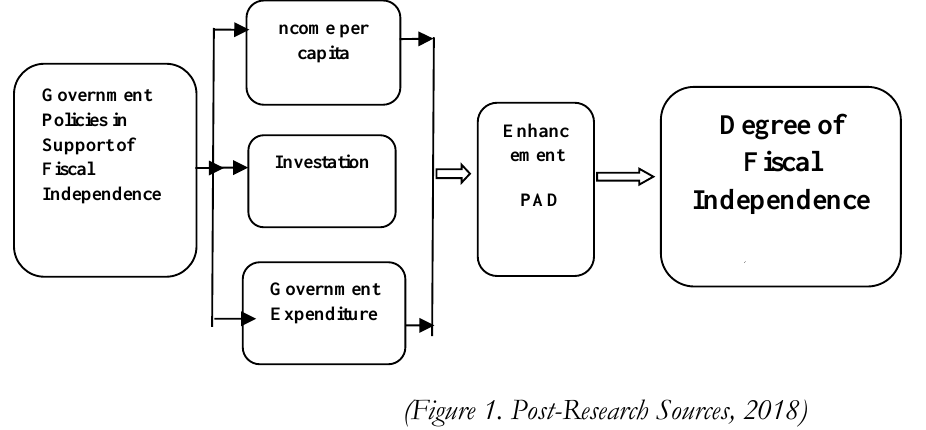
(Figure 1. Post-Research Sources,